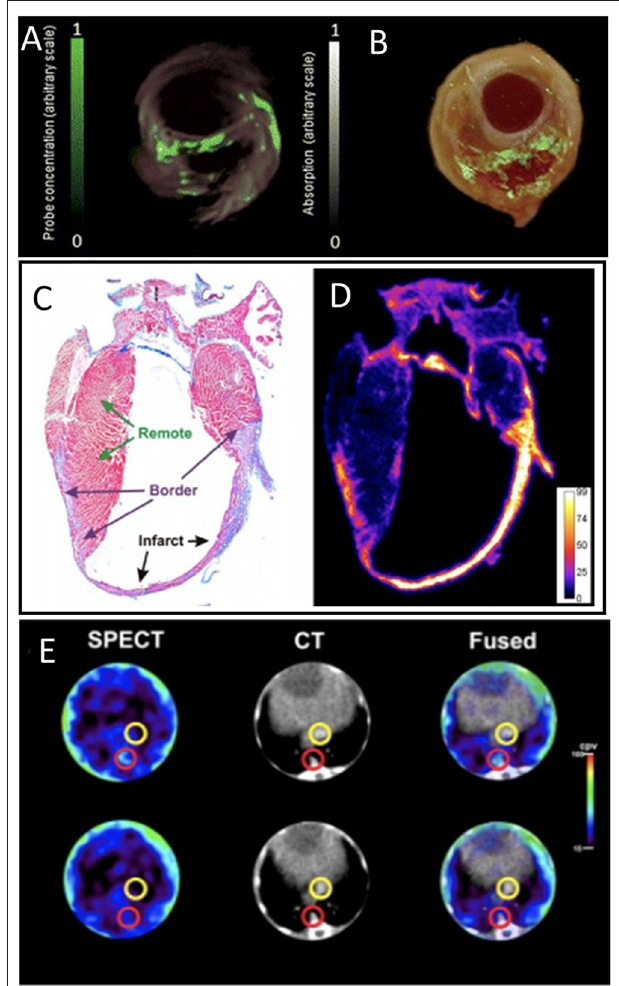
FIGURE 8 | Matrix metalloproteinase (MMP) activity imaging. (A) Imaging of intact plaques made using deep-tissue multispectral optoacoustic tomography. Cross-sectional multispectral reconstruction, revealing the location of MMPSense 680 activity in the slice (green) superimposed onto morphological optoacoustic images. (B) The corresponding epi-fluorescence images of a dissected plaque (in green) superimposed onto color images of cryosections from the three carotid plaque specimen [adopted from (15)]. Histology and autoradiography of a coronal section of the mouse heart 20h post-injection of 177 Lu-ACPP 10 days after myocardial infarction. (C) Representative azan staining showing infarct scar in blue and remote myocardium in red. (D) Autoradiography shows enhanced uptake of 177 Lu-ACPP in the infarct zone in an adjacent section [adopted from (98)]. (E) Transversal SPECT, CT, and fused SPECT and CT images of MMP activation using RP782 in atherosclerotic apoE − / − mice, demonstrating areas of high (top) and low (bottom) tracer uptake in aorta (red circles). Slight tracer uptake can be detected in IVC [yellow circles; adopted from (99)]. ACPP, Activatable cell-penetrating peptides; RP782, 111 In-labeled tracer specific to MMP